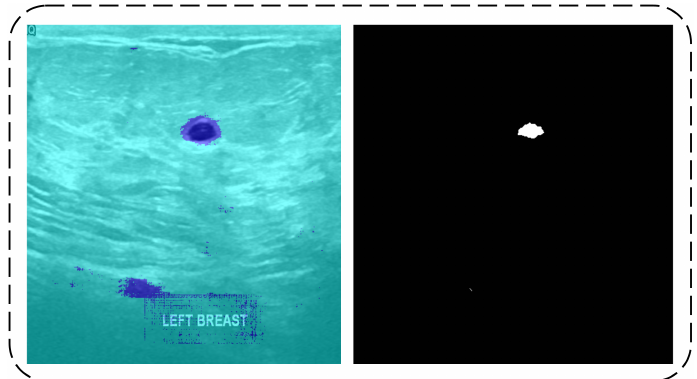
Figure 5. Di-CNN predicted results ( left ) and result after erosion operation ( Right